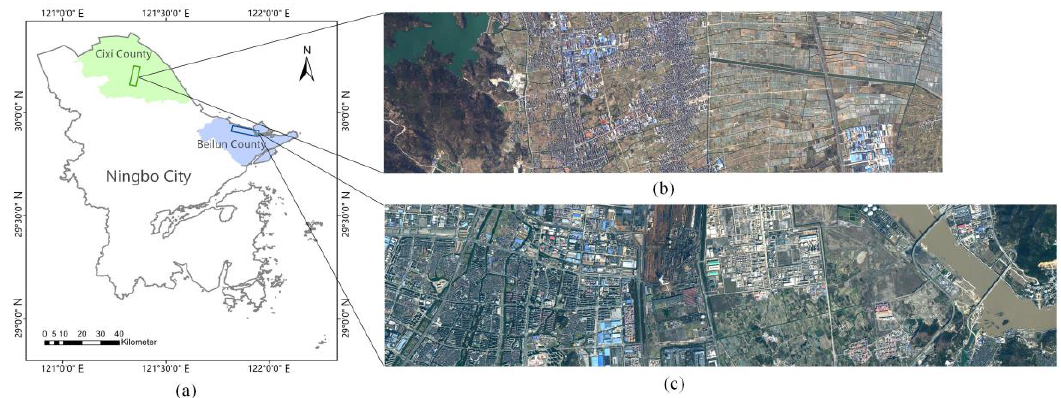
Figure 5. Study areas ( a ) and GaoFen-2 images of Beilun urban scenes ( c ) and Cixi rural scenes ( b ) in true color.